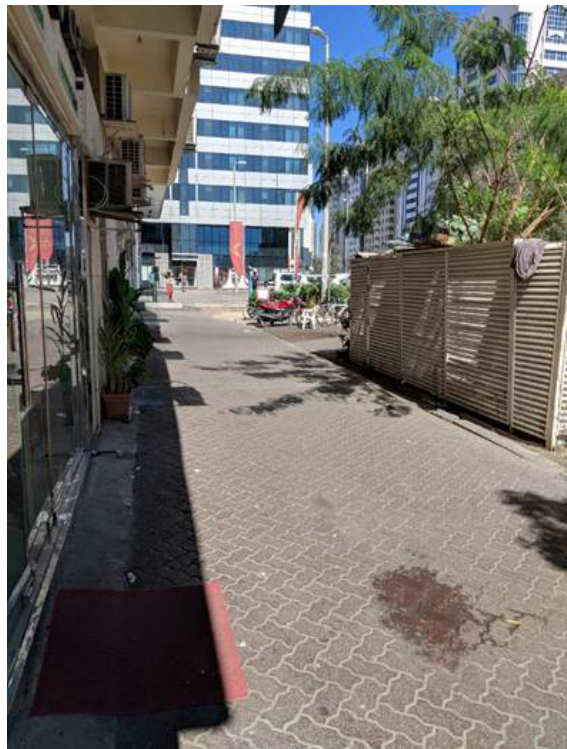
Users customise the public space, as is visible in the planters, the plants, the plastic chairs, and even the doormat. This is in contrast to the surrounding areas (Source: author).